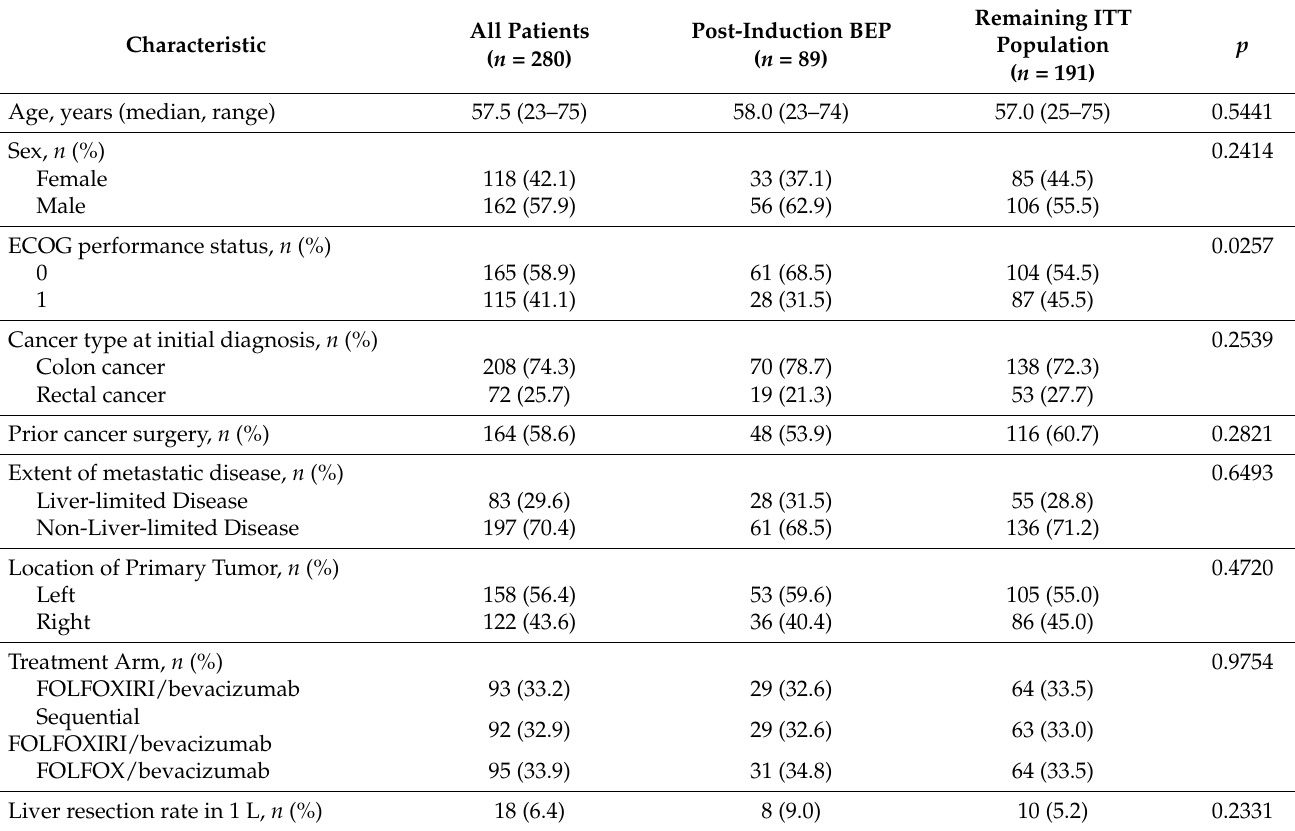
Table 2. Comparison of patient characteristics between post-induction BEP and